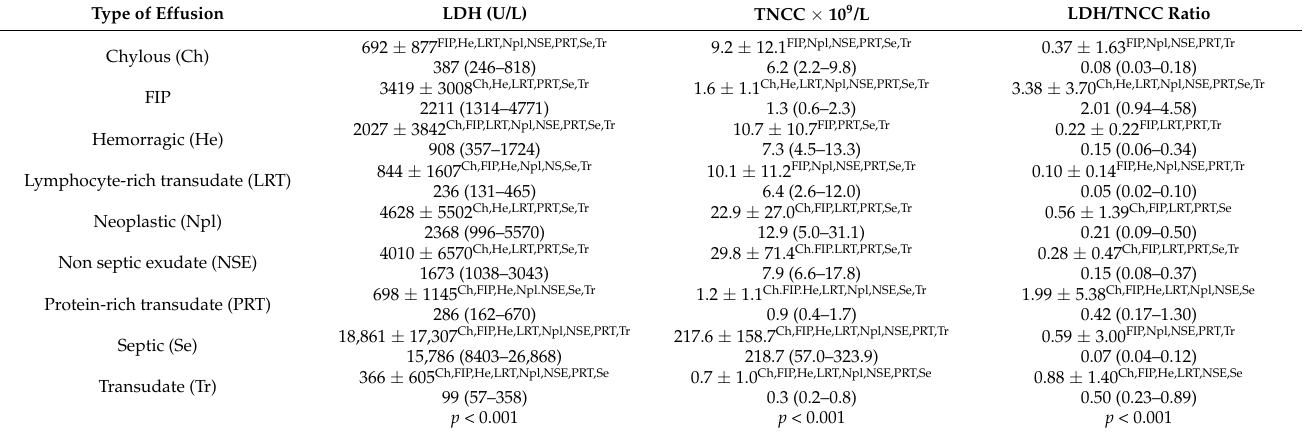
Table 5. Comparison of TNCC, LDH, and LDH/TNCC ratio in the effusions classified according to the cytological and physicochemical appearance (step 1). Results are expressed as mean ± standard deviation, median and between parenthesis I–III interquartile